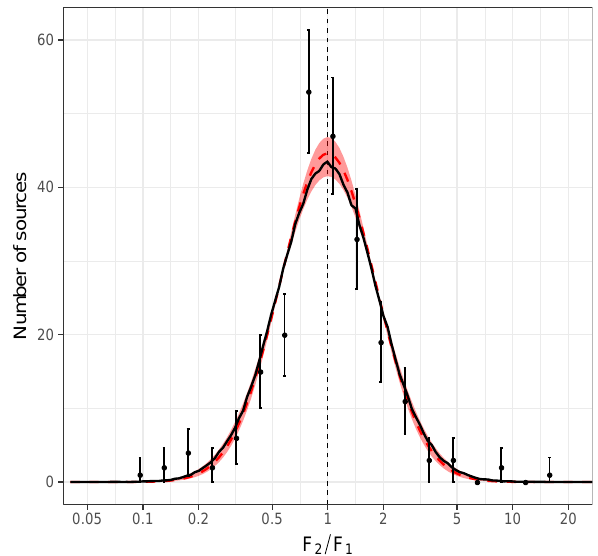
Fig. 6.— The distribution of the ratios of the observed fluxes for the primary sample are compared with the best fitting model. The data points show the number of sources in bins of flux ratio of constant width. The error bars show the Poisson uncertainty on the number of sources in each bin, using the Gaussian approximation of Gehrels (1986). The solid black line shows the distribution of flux ratios derived from a synthetic sample of sources generated from our best fitting model. The dashed red line and shaded 1 σ error envelope show the lognormal distribution with the best fitting √ variability of σ = 0 . 43 ± 0 . 03 multiplied by a factor of 2 . As discussed in the text, this factor accounts for the uncertainty on the mean of a pair of observations. The small difference between the two curves is due to the inclusion of statistical noise and sample selection effects in the curve derived from the synthetic sample. √ The geometric mean flux limit of F 1 F 2 > 2 . 5